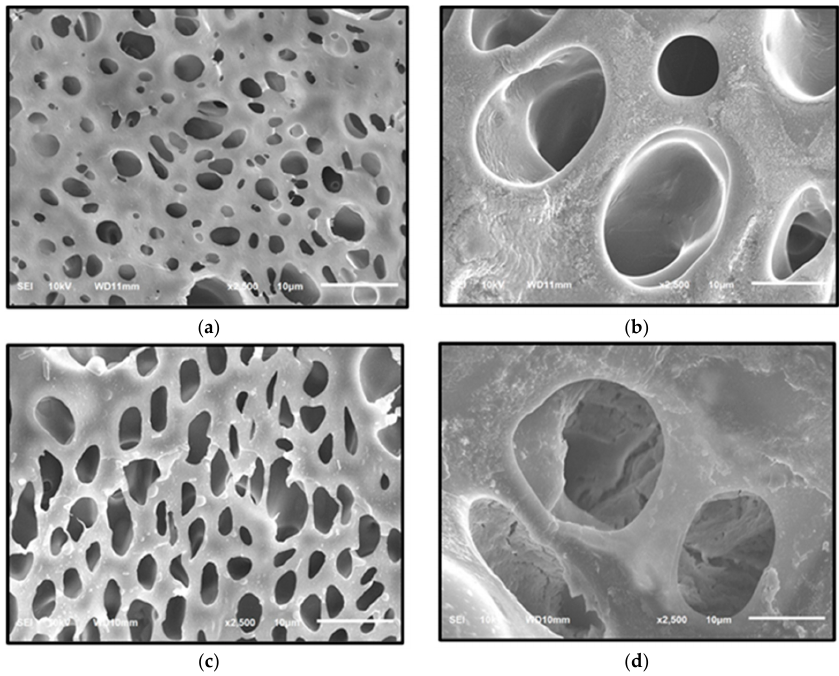
Figure 3. PMMA microstructures: ( a ) PS:PMMA; ( b ) PS:PMMA-H 2 SO 4 ; ( c ) PS:PMMA-HCl; ( d ) PS:PMMA-10% NaOH.